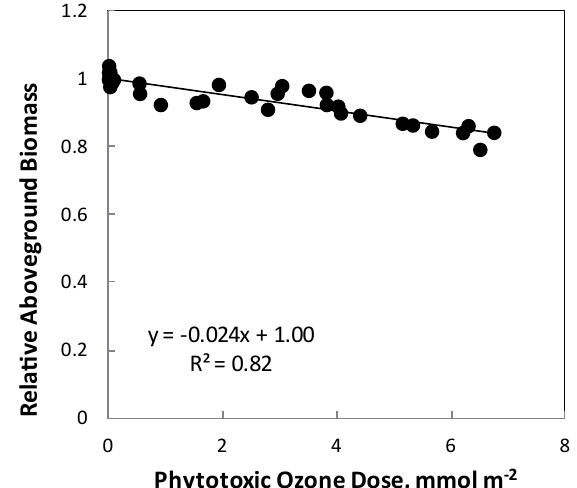
Figure 4. Relative harvest index vs. Phytotoxic Ozone Dose above a threshold of 6nmolm − 2 s − 1 (POD 6 ) based on 12 experiments from 3 countries (Belgium, Finland, Sweden). The relative scale is based on the assumption that there is no effect of ozone on harvest index at zero POD 6 in each experiment.